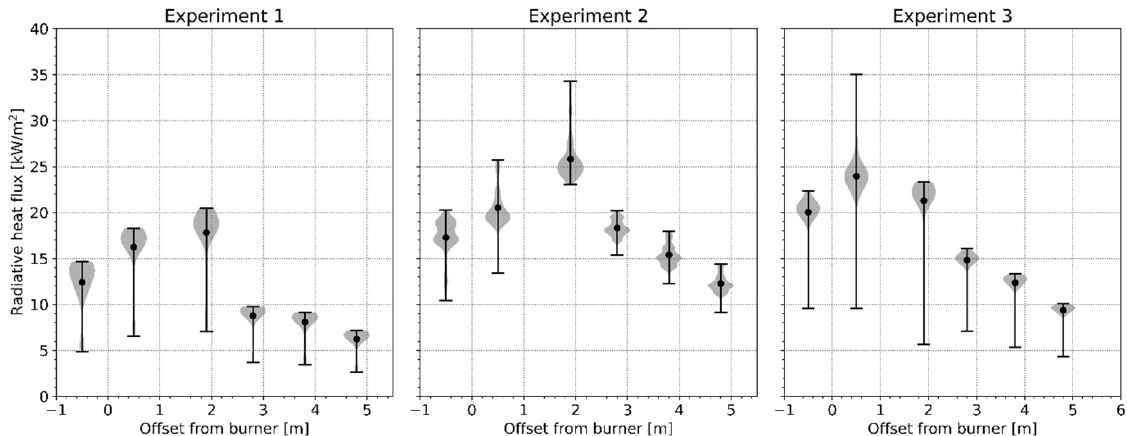
Figure 22. Violin plot of radiative heat flux to the floor for all experiments at different offsets from the burner array, indicating range, probability distribution and mean values, whilst burner array HRR = 1250 kW.